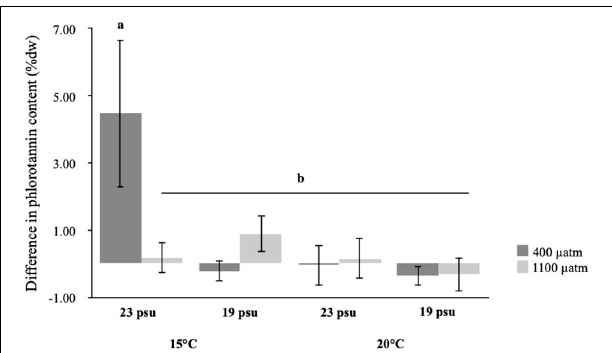
FIGURE 3 | Difference in phlorotannin content of the same individual of Fucus vesiculosus between ungrazed and grazed tissue by Littorina obtusata after exposure to different levels of temperature (ambient and high), salinity (ambient and low), and pCO 2 (ambient and elevated) as fixed, orthogonal factors. Letters denote statistically significant post-hoc groupings (SNK post-hoc test, p < 0.05). Values are means ± 95% CI, n =